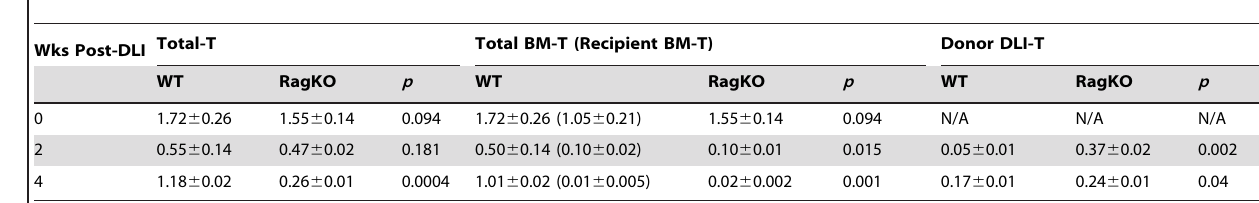
Table 1. Kinetics of bone marrow- and DLI-derived T cells in peripheral blood after DLI.